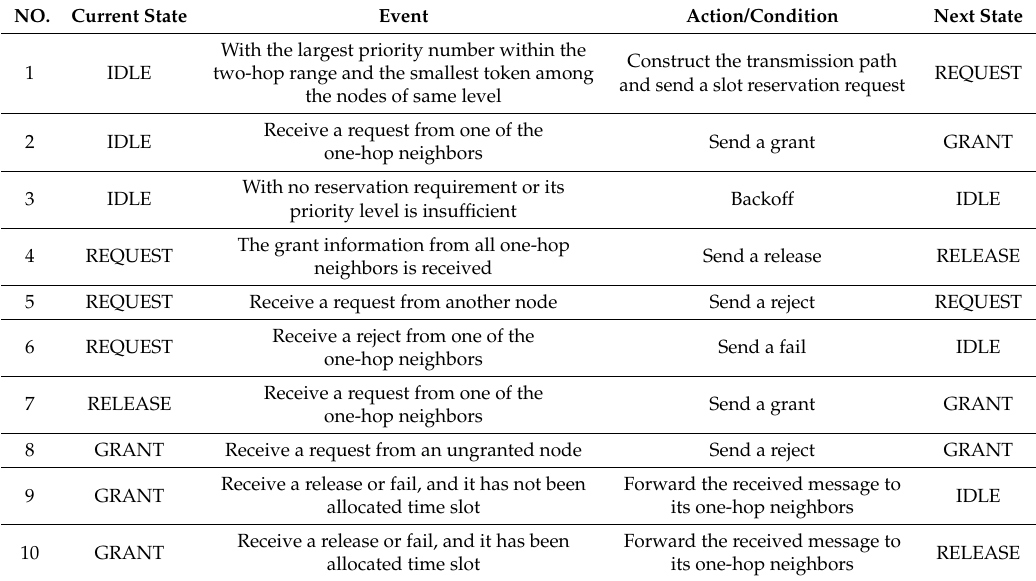
Figure 5. The state diagram of the SP-DS algorithm implementation. Table 2. The state transition table of SP-DS